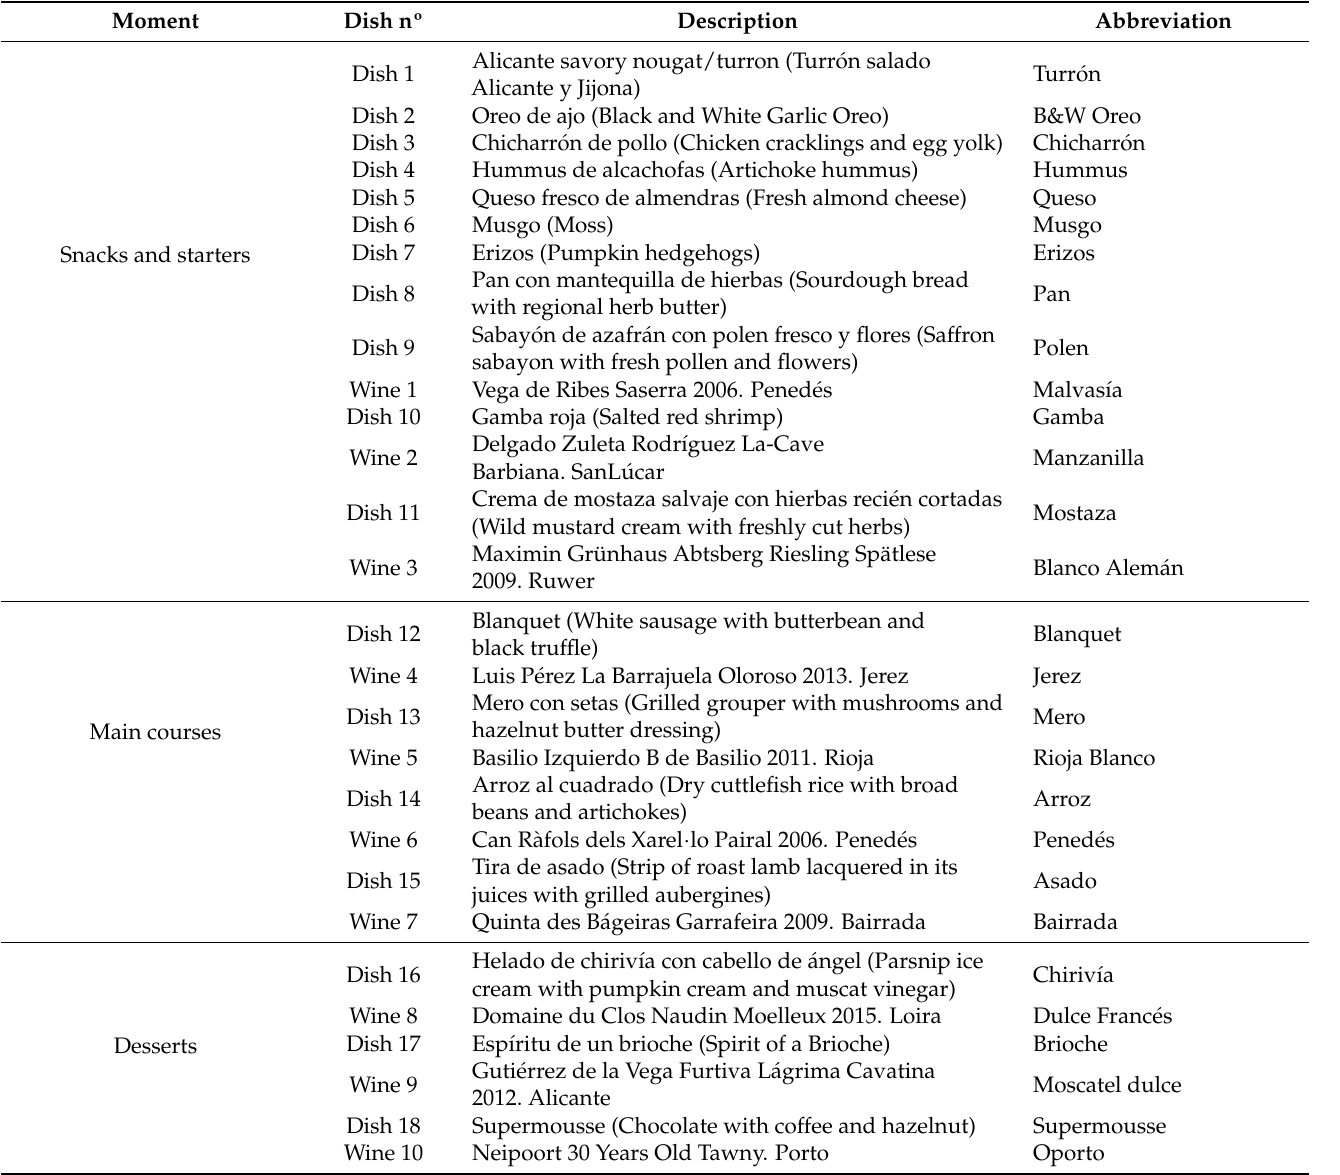
Table 1. Stimulus description. Source: Original work from the authors.